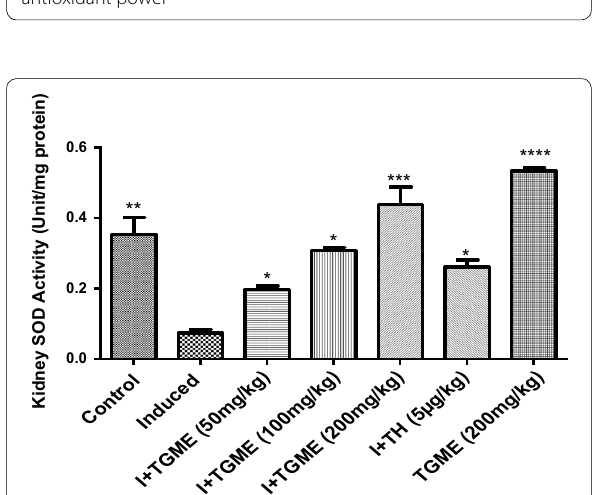
Fig. 14 Effect of aqueous methanolic leaf extract of Triclisia gilletii on Fig. 12 Effect of aqueous methanolic leaf extract of Triclisia gilletii on MPO activity in the kidney of animals administered ethane-1,2-diol. SOD activity in the kidney of animals administered ethane-1,2-diol. Data are expressed as mean SEM of 6 rats ( n 6); ** p < 0.01, Data are expressed as mean SEM of 6 rats ( n 6); * p < 0.05, ± = ± = *** p < 0.001, and **** p < 0.0001; *denotes that data were compared ** p < 0.01, *** p < 0.001, and **** p < 0.0001; *denotes that data with ethane-1,2-diol; TGME Triclisia gilletii aqueous methanolic extract, were compared with ethane-1,2-diol; TGME Triclisia gilletii aqueous TH tamsulosin hydrochloride, MPO methanolic extract, TH tamsulosin hydrochloride, SOD superoxide dismutase